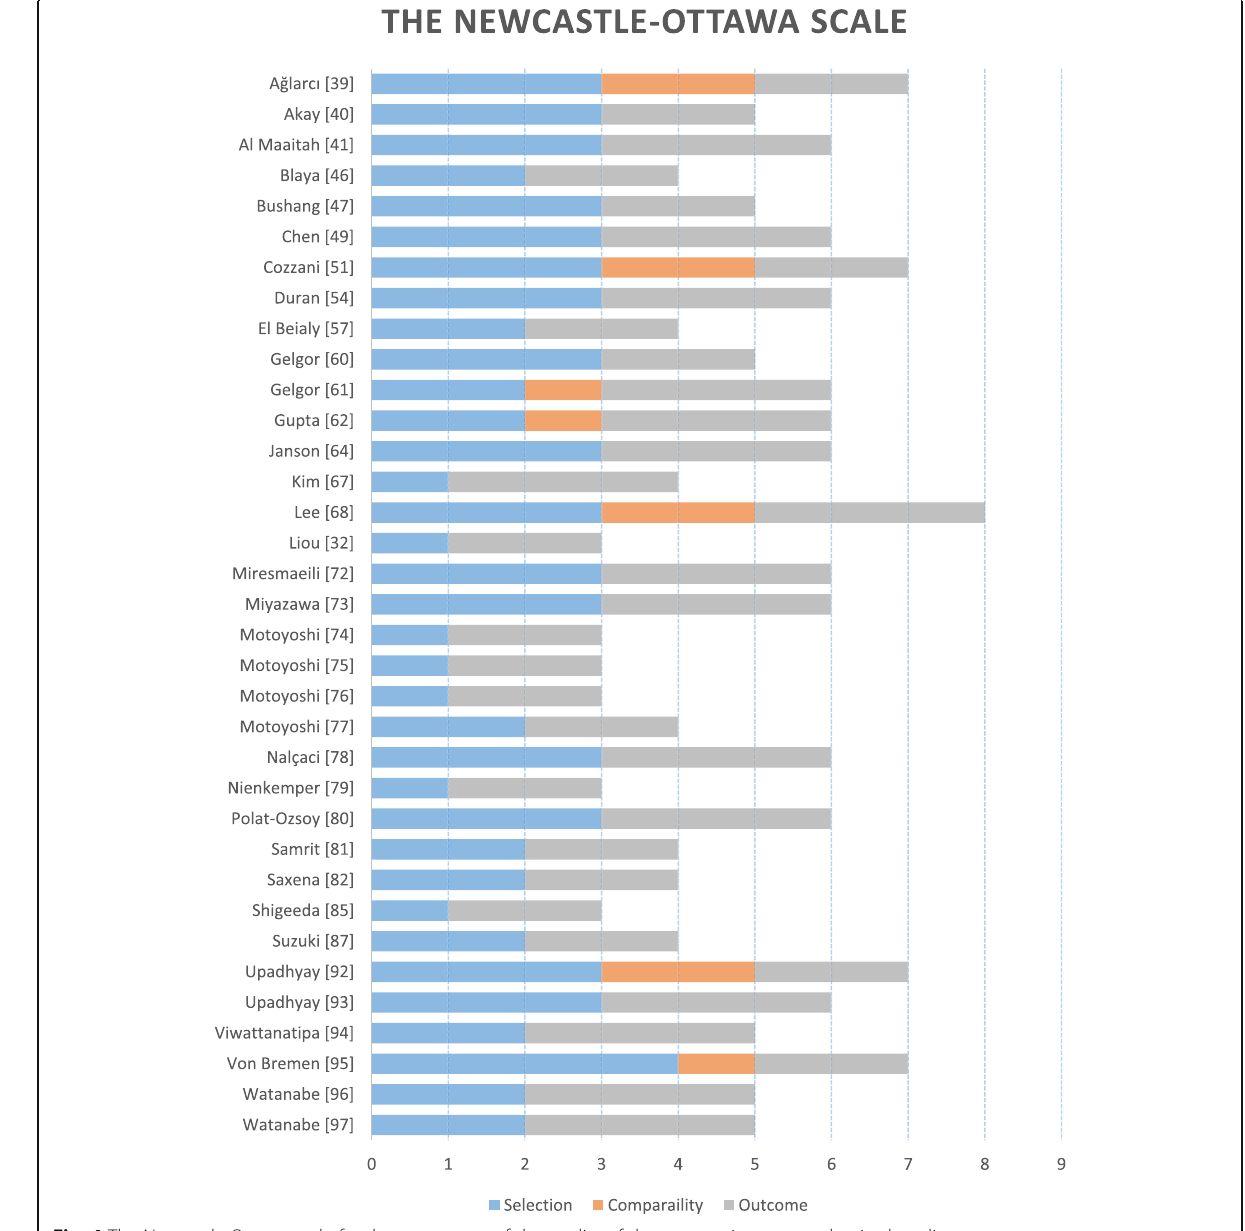
Fig. 4 The Newcastle-Ottawa scale for the assessment of the quality of the prospective non-randomised